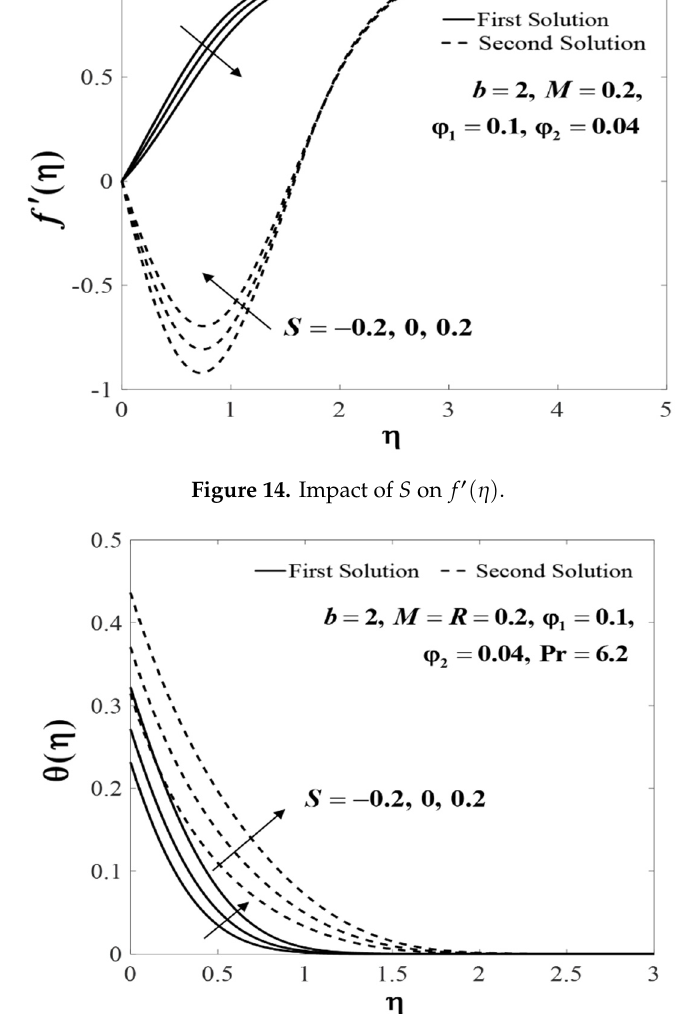
Figure 13. Impact of 𝑀 on 𝜃(𝜂) .